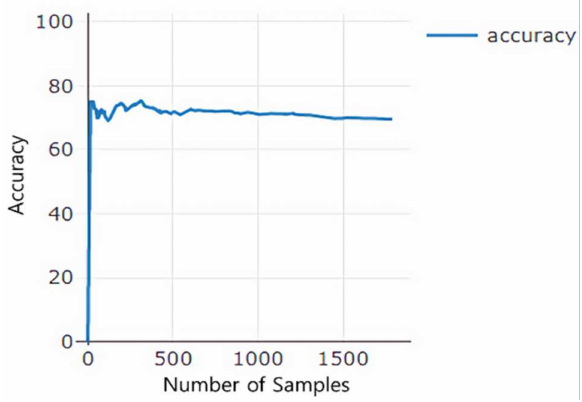
Figure 13. Accuracy of second test data